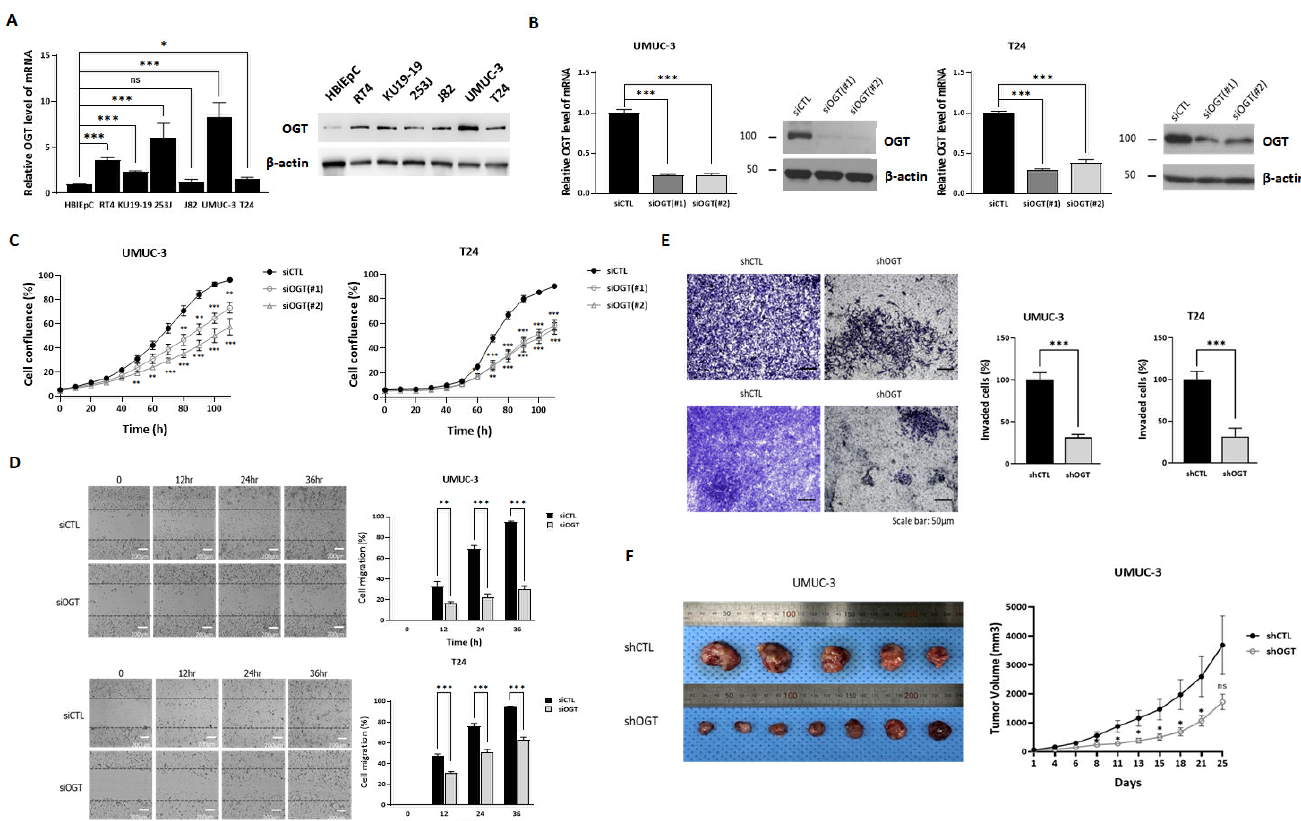
Figure 1. Downregulation of O-linked β -N-acetylglucosamine (O-GlcNAc) transferase (OGT) in urothelial carcinoma of the bladder (UCB) cells via gene targeting attenuated cell growth, cell migration and invasion, and tumor growth in vivo. ( A ) Western blot (WB) and qRT-PCR examination of OGT expression in human bladder epithelial cells and UCB cells. ( B ) WB and qRT-PCR examination of OGT expression in UMUC-3 and T24 UCB cells reverse transfected with control siRNA (siCTL) or siOGT. ( C ) UMUC-3 and T24 cells were reverse transfected with siCTL or two pairs of siOGT and incubated in the IncuCyte TM analyzer to monitor cell proliferation. Cell confluence levels were measured in real time using the IncuCyte TM analyzer and are presented as a percentage. ( D ) Wound healing assay of cell migration in UMUC-3 and T24 cells reverse transfected with siCTL or siOGT. Migrated cell images were acquired with Operetta CLS at 0, 12, 24, and 36 h. ( E ) Boyden Chamber assay analysis of the in vitro invasion capability of UMUC-3 and T24 cells stably expressing shCTL or shOGT. Cells were incubated for 48 h. ( F ) Tumor volume over time in nude mice injected subcutaneously with 5 × 10 6 shCTL or shOGT UMUC-3 cells. Tumors were measured when average tumor size reached 40 mm 3 . After 4 weeks, the tumors were removed for morphological and histological examination. Representative images of tumors from shCTL (top) and shOGT cells (bottom) are shown. In panels ( A – E ), the data represent at least three independent experiments and error bars indicate mean ± SEM. * p < 0.05; ** p < 0.01; *** p <